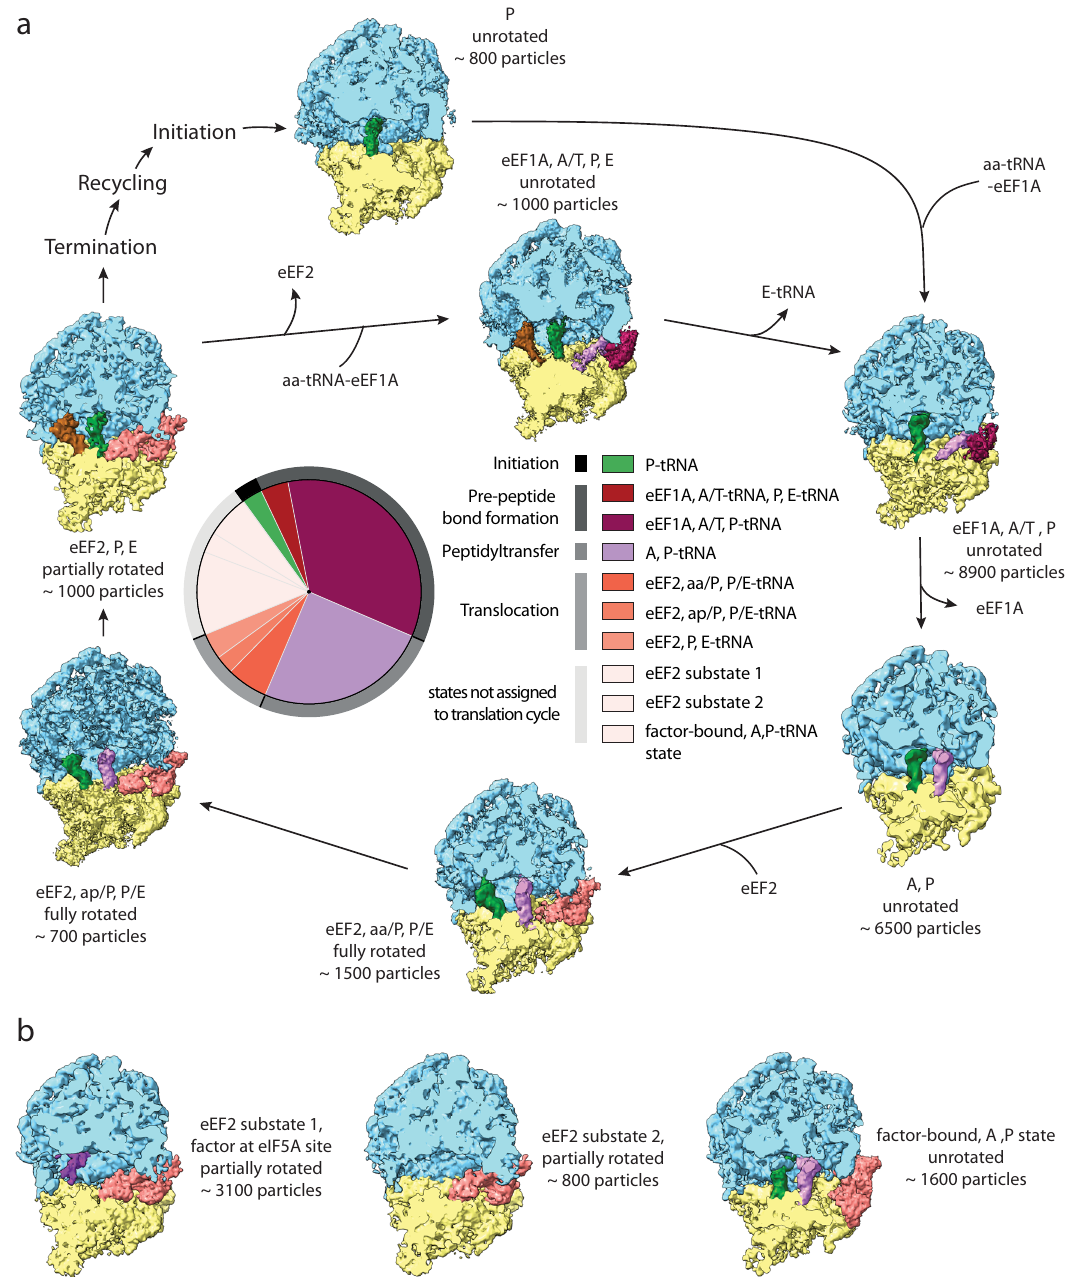
Fig. 3 |Translationalstatesofthe80S eukaryotic ribosomein situ. a Schematic of the ribosomal translation cycle. Seven ribosome states of the translation cycle couldbeidenti fi ed.Thetwomostprominentstatesare(1)eEF1A,A/T,Pand(2)A,P with a third and a quarter of the particles, respectively. Particle numbers for each state are rounded to the next hundred. The tRNA positions are labeled in accor- dance to the proximity of their anticodon stem-loop (ASL) to the canonical tRNA binding sites on the smallsubunit.The state aa/P refers to anintermediate state of tRNA for which ASL is closer to the canonical A-site, than the P-site. The ap/P state